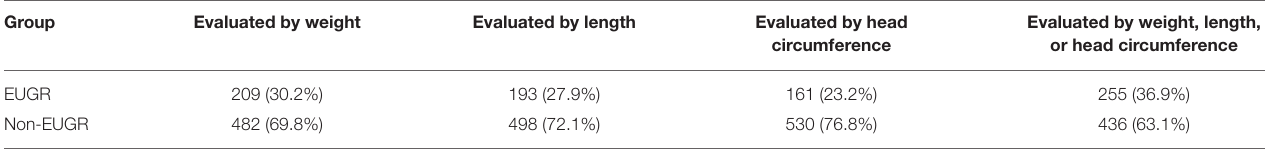
TABLE 1 | The percentage of preterm infants in the EUGR and non-EUGR groups evaluated by weight, length, or head circumference ( n = 691).